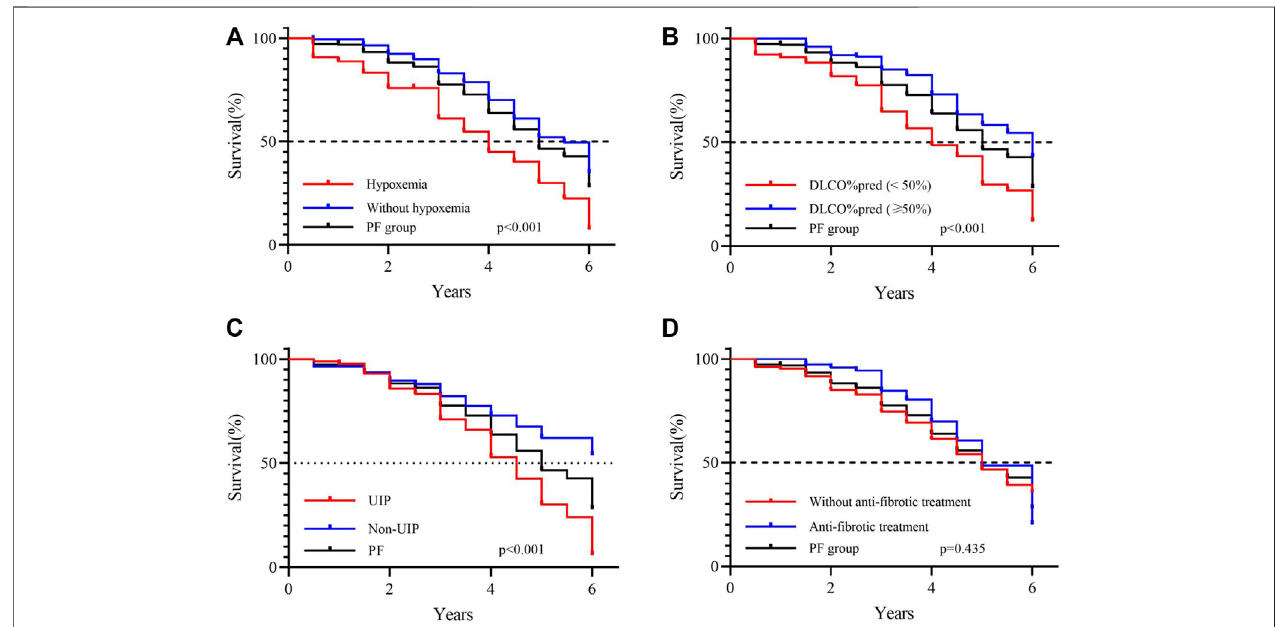
FIGURE3| Survivalinpatients withprogressive fi brosingILD. (A) Survivalaccordingtowithorwithouthypoxemiaatbaseline(log-ranktest, p < 0.001); (B) survival according to DLCO% pred at baseline with a 50% threshold (log-rank test, p < 0.001); (C) survival according to the UIP-like fi brotic pattern on HRCT (log-rank test, p < 0.001); (D) survival according to with or without anti- fi brotic treatment during observation (log-rank test, p = 0.435).